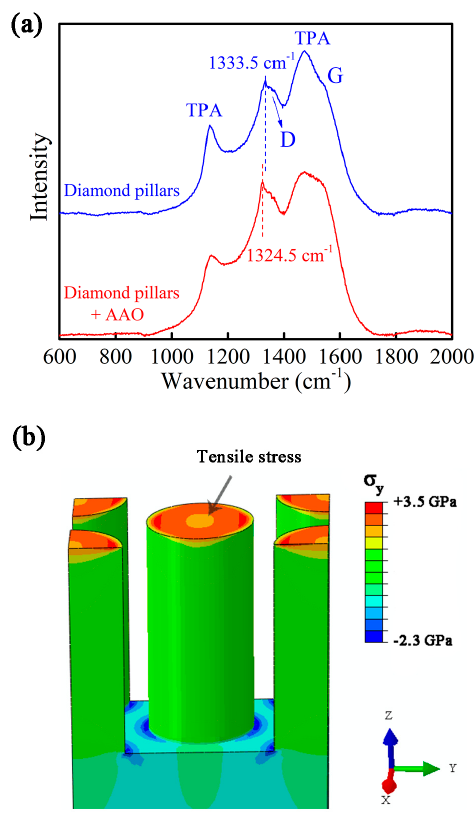
Figure 6. ( a ) Raman spectra of the diamond pillars (~325 nm in diameter) before and after removal of the AAO template. ( b ) Stress modeling data showing the contour plot of the residual stress along the y-axis in the diamond pillars after the cooling down and before AAO removal. For reasons of clarity, the AAO skeleton is not shown. Table 1. Diamond peak parameters evaluated from the Raman spectra of the various NCD